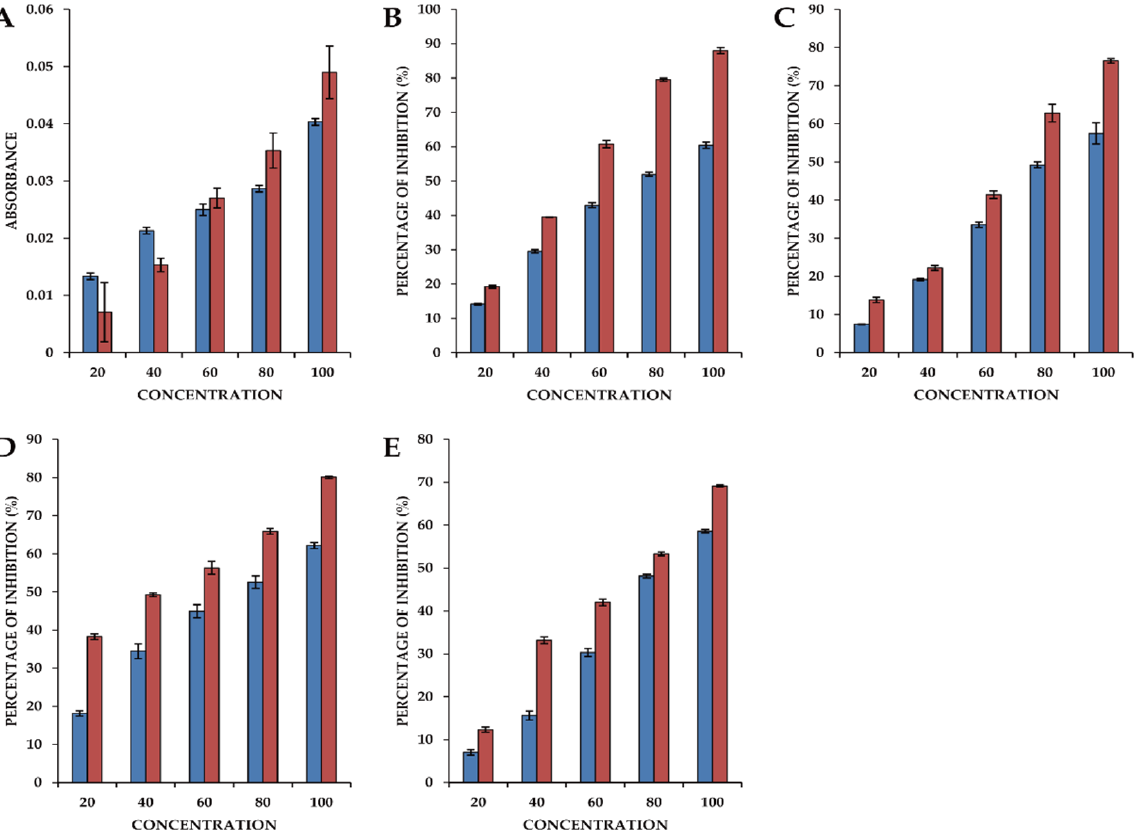
Figure 7. The antioxidant activity of an ethyl acetate extract of Lavandula pubescens leaves. ( A ) Reducing power activity; ( B ) 2,2-diphenyl-1-picrylhydrazyl (DPPH) radical scavenging activity; ( C ) Hydrogen peroxide scavenging activity; ( D ) Superoxide radical scavenging activity; ( E ) Hydroxyl radical scavenging activity. The blue bars represent values obtained using an ethyl acetate extract of L. pubescens leaves and the red bars are values obtained using ascorbic acid.